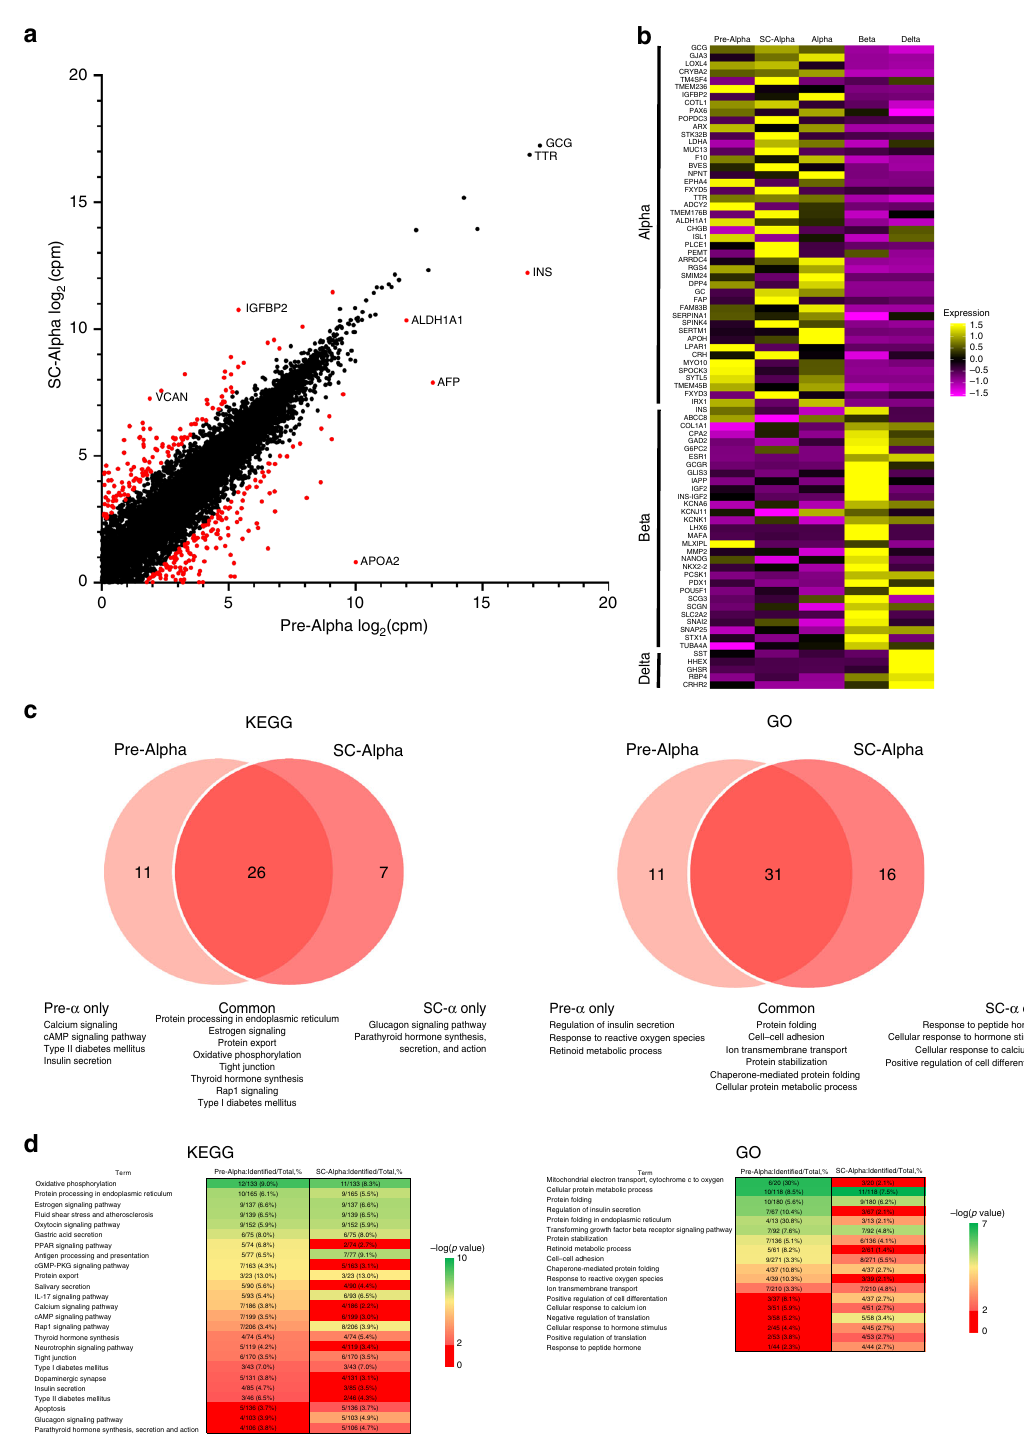
Fig. 4 Molecular characterization of pre-alpha cells and SC-alpha cells. a Scatterplot showing relative expression of pre-alpha ( x -axis) and SC-Alpha ( y -axis) transcript counts. Both axes are log2(cpm). Genes with fold change greater than 0.5 or less than − 0.5, and p value < 0.01 as calculated using a Wilcoxon rank sum test, are highlighted in red. b Heatmap showing pre-alpha and SC-Alpha cells in comparison with human alpha, beta, and delta cells. Top 46 genes are alpha cell speci fi c, middle 31 genes are beta cell speci fi c, and bottom 5 genes are delta cell speci fi c. Coloring is based on z -score from 1.5 as high (yellow) to − 1.5 as low (purple). c Venn diagrams comparing KEGG pathway (left) and Gene Ontology-Biological Process (right) database overlap between the highest expressing 150 genes in pre-alpha and SC-Alpha cells. Signi fi cant terms de fi ned as p value < 0.01 as calculated using an EASE Score (modi fi ed Fisher Exact test). d Heatmaps showing selected pathways from KEGG and Gene Ontology-Biological Process terms for pre-alpha and SC-Alpha cells. Columns show number of genes mapped to the pathway divided by number of possible genes in the pathway, in addition to its percentage. Scale is from – log( p value) of 2 (light red) to 10 (green) for KEGG and – log( p value) of 2 (light red) to 7 (green) for GO-BP. All pathways that were not signi fi cant as calculated using an EASE Score (modi fi ed Fisher Exact test), i.e. – log( p value) from 0 to 2, are labeled in red. Full heatmaps are shown in Supplementary Figs. 14 and